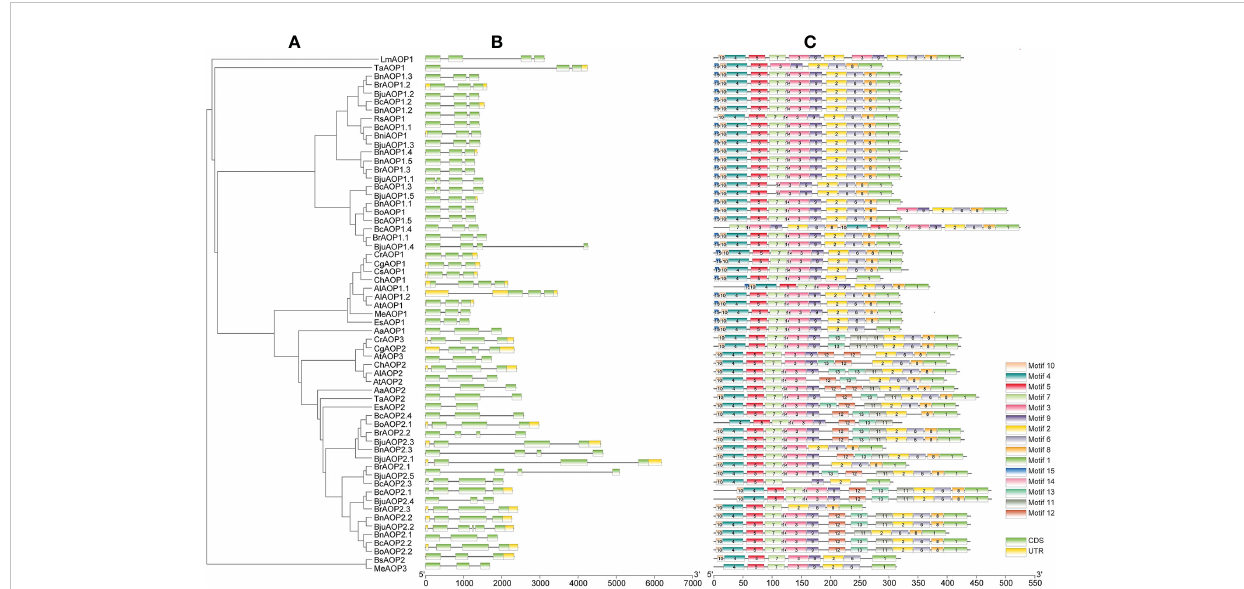
FIGURE 3 Gene structures and motifs of 61 AOP genes identi fi ed in B juncea and other sequenced Brassicaceae crops. (A) unrooted phylogenetic relationships among the AOP protein sequences. (B) exon-intron organization of corresponding AOP gene. Exons are represented by green boxes, while introns are represented by gray lines. (C) conserved motifs of AOP genes. Colored boxes indicated conserved motifs and gray lines represent non- conserved sequences. The length of motifs in each protein was showed